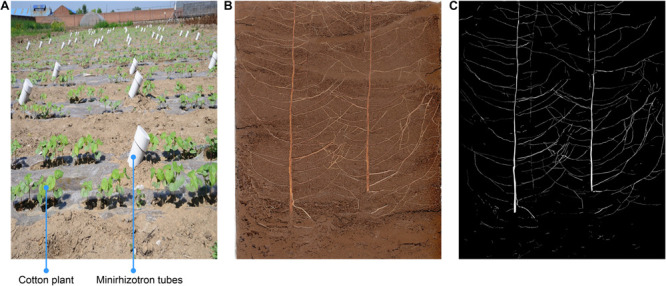
Minirhizotron installation and image annotation. (A) Minirhizotron tubes were installed at a 45° angle, parallel to the plant rows, and at a distance of 25 cm from the cotton plants in adjacent rows (halfway between rows), (B) Original image, (C) annotation image.